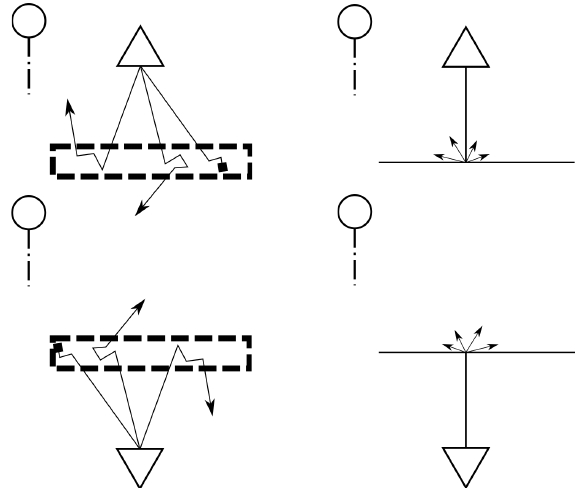
Figure 1. Schematic presentation of the rendering scene. The sunlamp is shown as a circle and its direction as a dashed line. Camera is represented by a triangle and cast rays as solid lines. Absorbed rays end with a square and scattered rays with an arrow. The leaf volume is presented by dashed box. Top row shows the camera in reflectance imaging position and bottom row in transmittance imaging position. Left column shows leaf target imaging and right column reference imaging